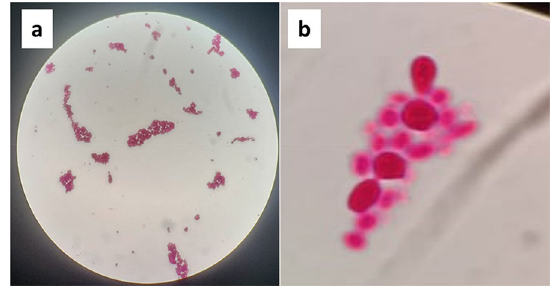
Fig. 1 Appearance of a S. cerevisiae isolate under a light microscope using 20X ( a ) and 100X ( b ) magnification lenses